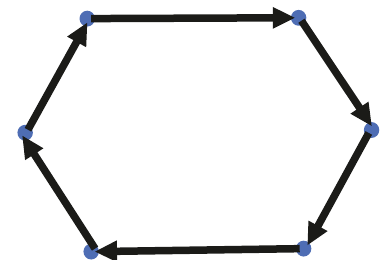
Figure3:Graphicalrepresentationofthefamilyofunicycledirected